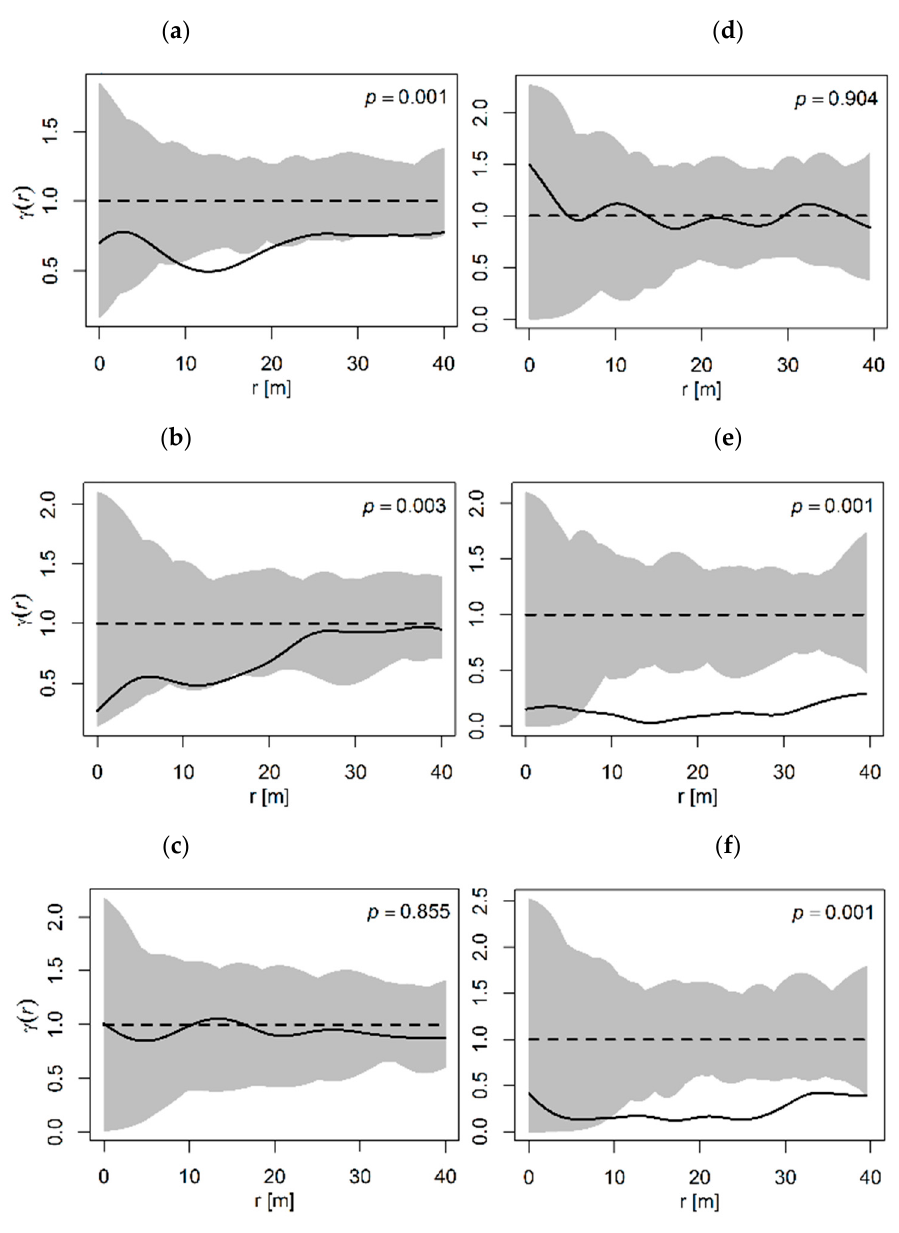
Figure 6. Spatial autocorrelation (mark variogram γ (r)) of Pinus cembra size classes. The solid line shows observed γ (r) values, the dashed line denotes the CSR and the gray area represents the confidence envelope. ( a , d ): Intermediate–Sapling, ( b , e ): Adult–Sapling, ( c , f ): Adult–Intermediate.